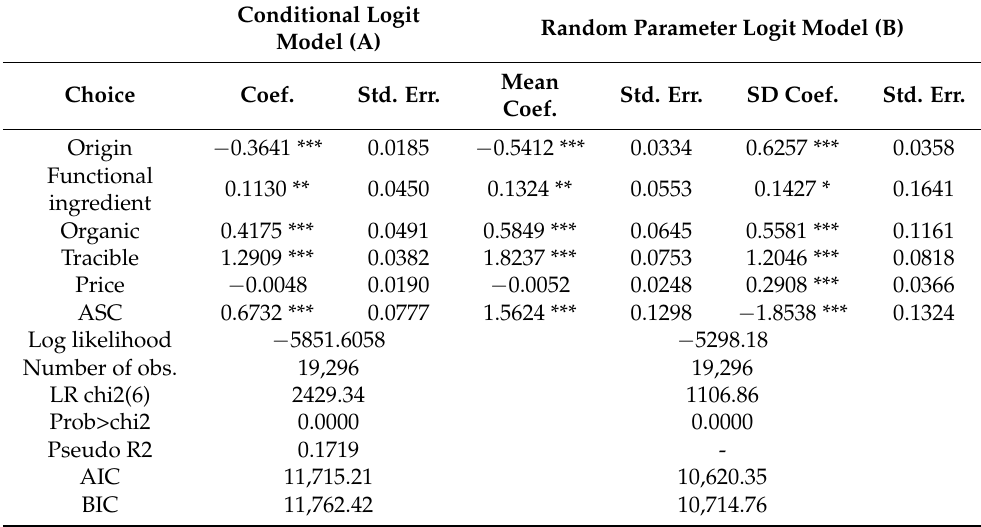
Table 3. Results of conditional logit and random parameter logit main